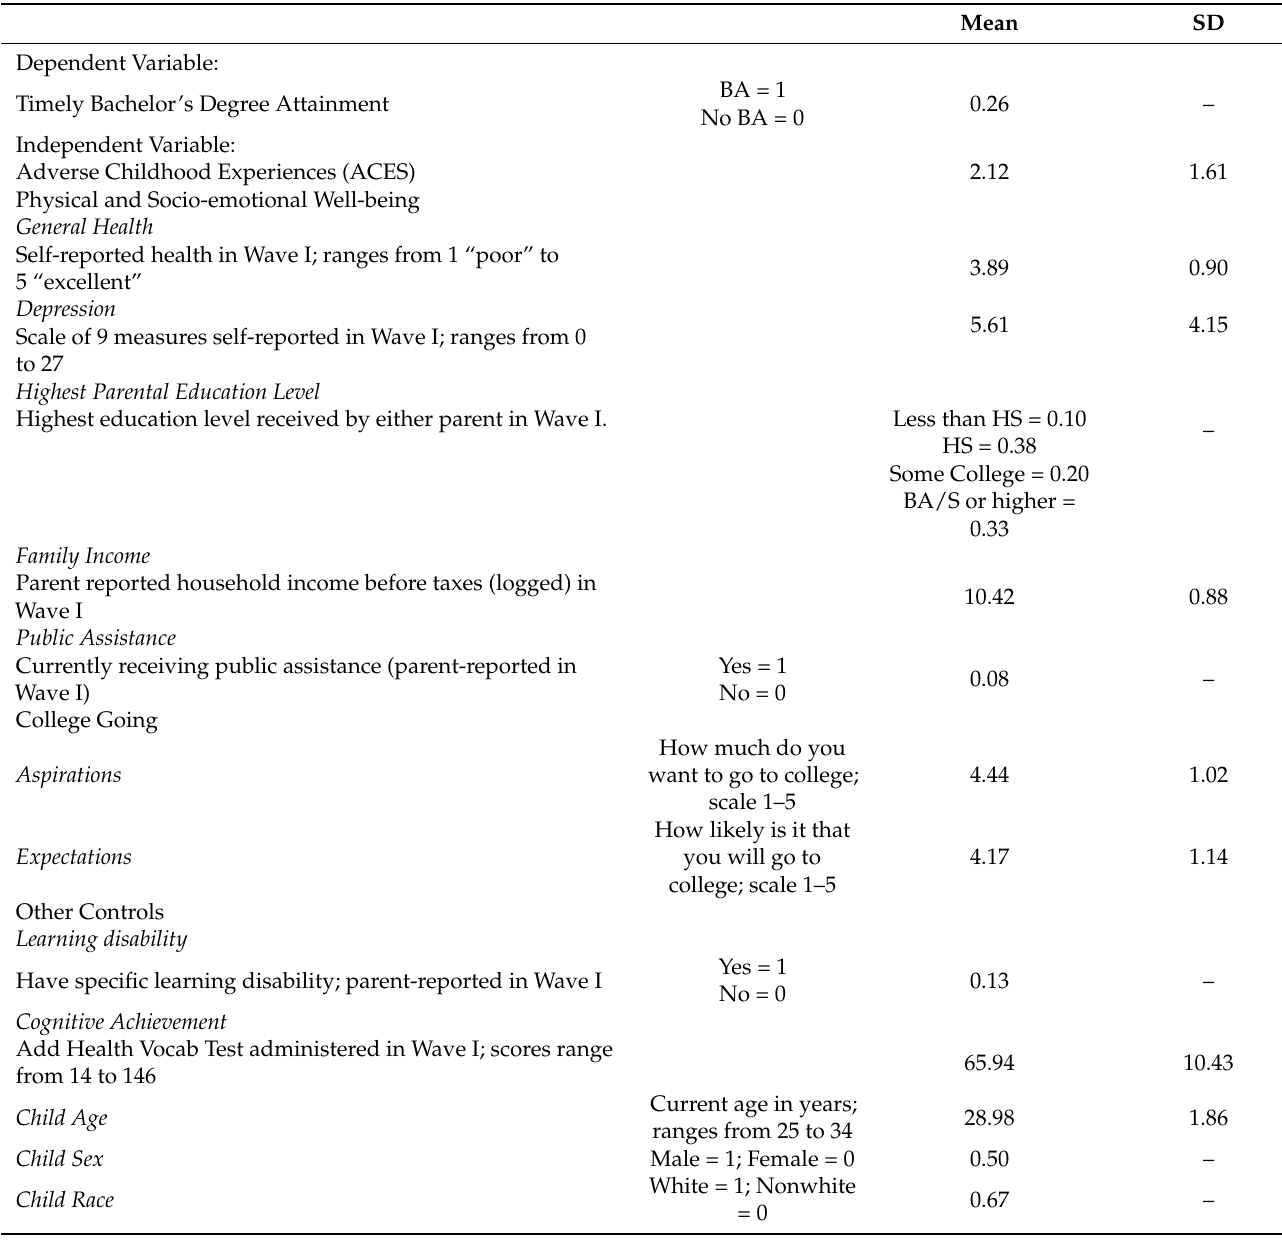
Table 1. Description of Variables